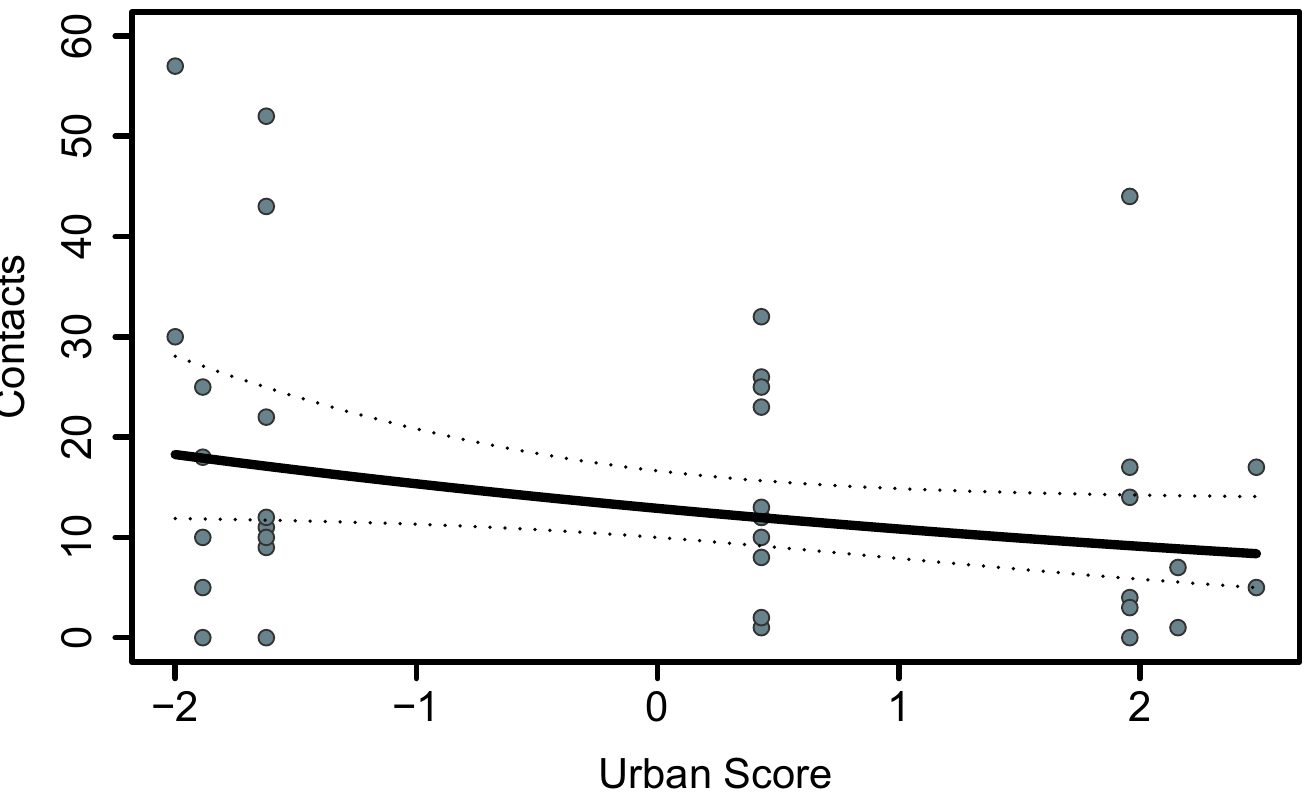
Fig 5. Relationship between number of contacts with the paper-ripping task and urbanisation of the habitat. A higher urban score corresponds to more urbanised sites. The slope and 95% confidence interval reflect the model estimate for this variable when holding all other variables in the global model at their mean.